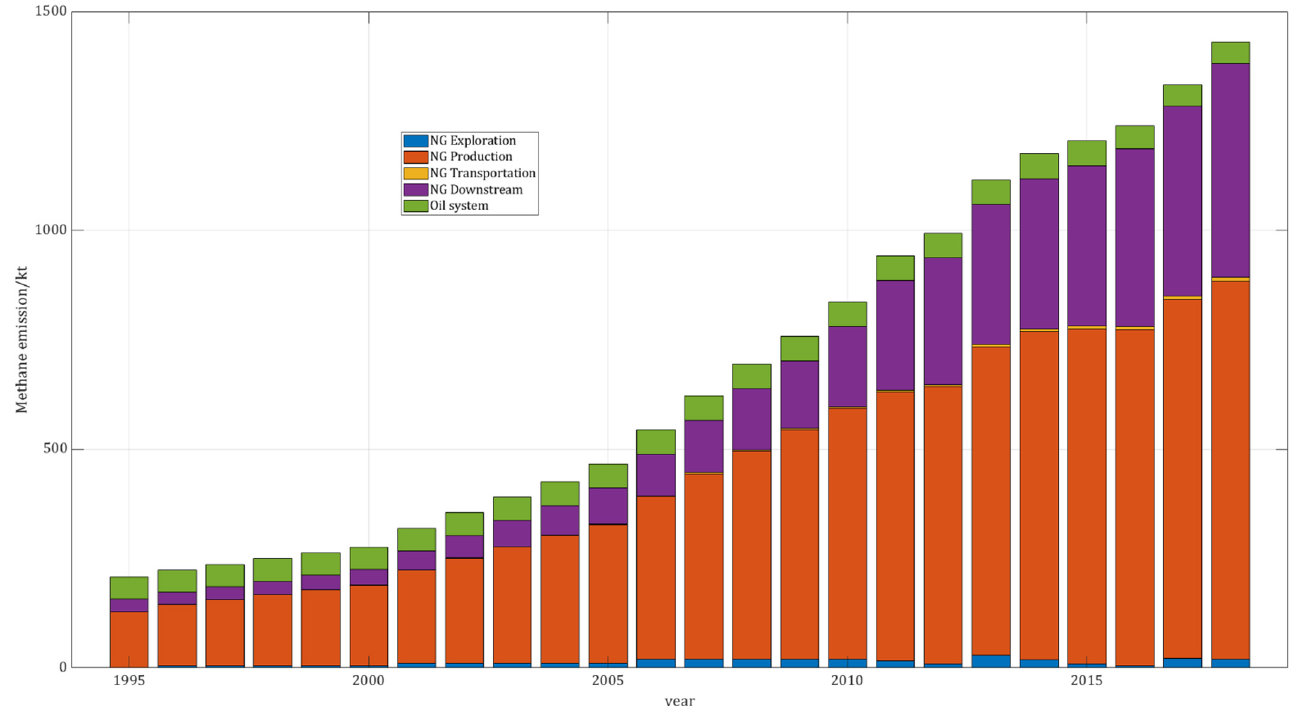
Figure 4. Methane emissions at different stages in the oil and natural gas